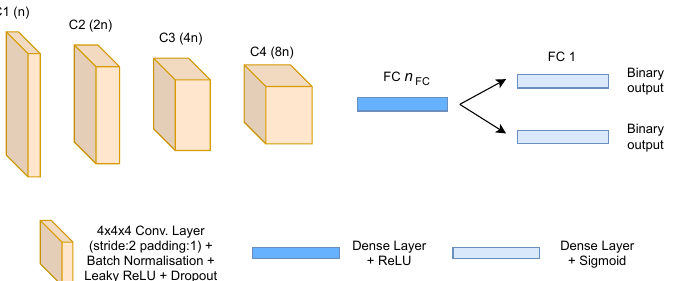
Figure 4. Proposed discriminator architecture. As illustrated, this network embodies four blocks of convolutional layers with 4 × 4 × 4, a stride of 2 and a padding of 1 for down-sampling, as well as one dense layer in the backbone followed by two classification heads. Each convolutional layer is followed by batch normalisation and uses Leaky ReLU (with a negative slope of 0.2) as the activation function. A dropout layer [28] was added after each of these convolutional blocks to decrease the number of trainable parameters, reducing overfitting. This regularisation strategy, which consists of randomly dropping out neurons during training with a certain defined probability, has the additional benefit of promoting a more robust feature extraction. Similarly to the decoder network, the number of filters increases as the network becomes deeper. Lastly, a dense layer with a variable number of neurons was included prior to the classification